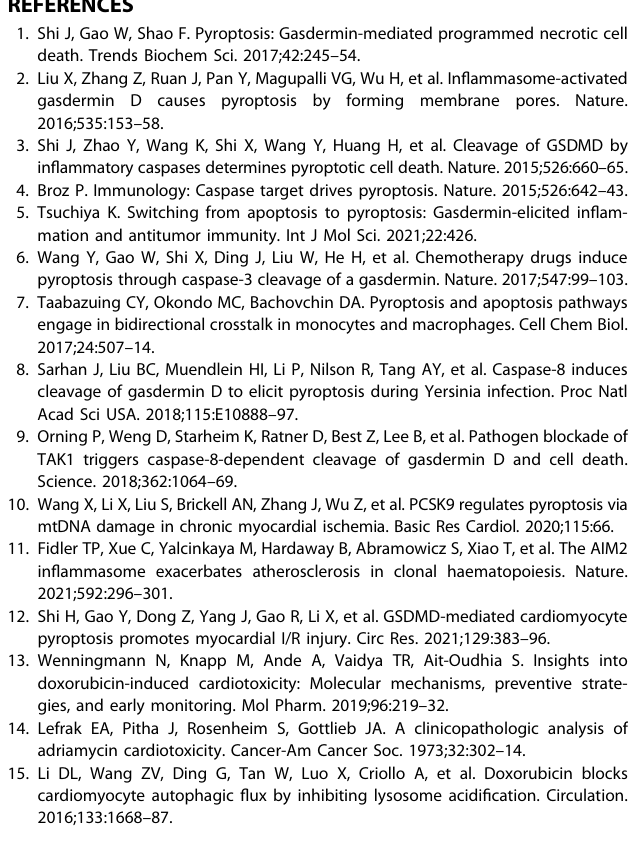
Fig. 7 FAM134B functions downstream of GSDMD/ERS to regulate DIC. A Survival curve of GSDMD ( fl ox/ fl ox) and GSDMD-CKO mice after DOX and 4PBA treatments was created by Kaplan – Meier method. N ≥ 15 per group. B , C Representative echocardiograms from GSDMD ( fl ox/ fl ox) and GSDMD-CKO mice treated with DOX and 4PBA are shown. Heart rate (HR), ejection fraction (EF) and fractional shortening (FS) are measured by echocardiography. N = 7 per group. D , E Western blot detection of Cleaved-caspase 3 (Cleaved cas3), BAX, LC3, Bip, and FAM134B protein abundance from mice after DOX and 4PBA treatments. Quanti fi cation of protein abundance as illustrated in panel. N = 6 per group. F – H Western blot detection of Cleaved-caspase 3 (Cleaved cas3), BAX, LC3, Bip, and FAM134B protein abundance in cardiomyocytes after DOX treatments. Quanti fi cation of protein abundance as illustrated in panel. N = 6 per group. I Working model by which how GSDMD induces cardiotoxicity after DOX administration. Data are depicted as the mean ± SEM. Statistical signi fi cance was determined by one-way and two- way ANOVA with a post hoc Holm – Sidak test, ns, not signi fi cant; * P < 0.05; ** P < 0.01; *** P < 0.001; **** P <